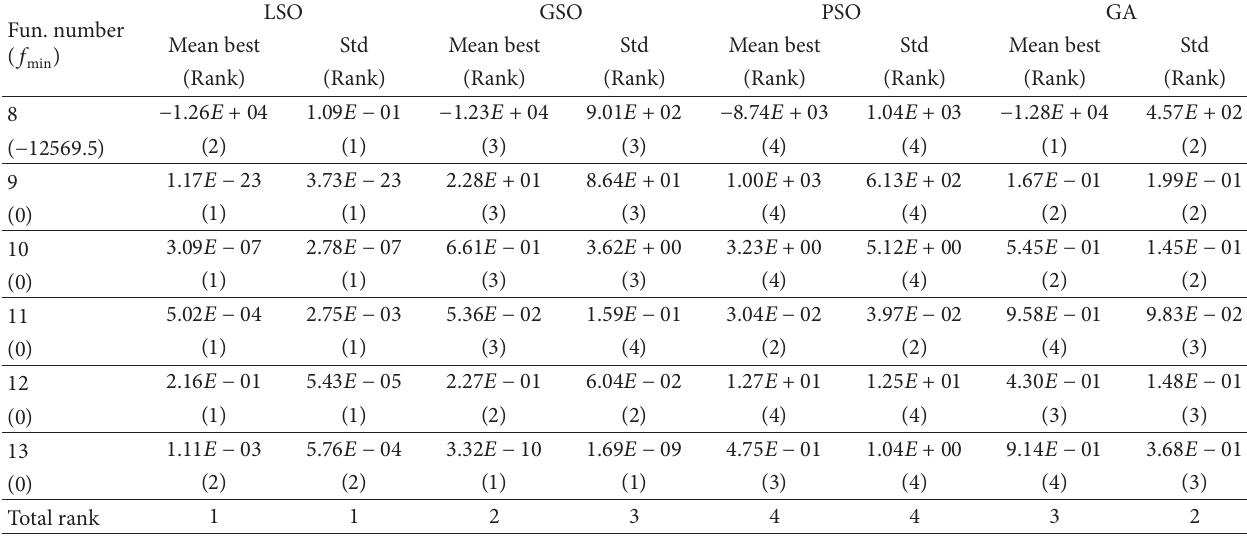
Table 2: Results for all algorithms on benchmarks functions 𝑓 8 to 𝑓 13 .